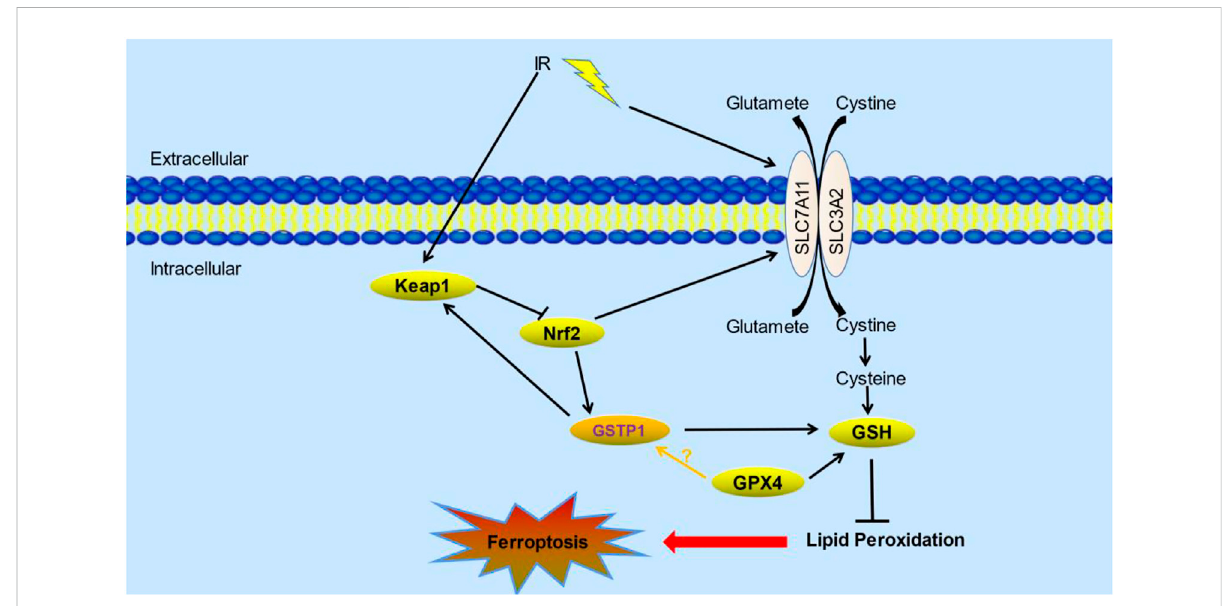
FIGURE 1 The potential role of GSTP1 and its mechanisms of ferroptosis in radiotherapy. Keap1-Nrf2-GSTP1 positive feedback loop interacts with GPX4 and SLC7A11 which are the core proteins in ferroptosis pathway under radiation. Their interactions affect lipid peroxidation, thus inhibiting the occurrence of ferroptosis (Liu et al., 2021; Wu et al., 2022). (IR: ionizing radiation; Keap1: kelch-like ECH associated protein 1; Nrf2: nuclear factor erythroid 2-related factor 2; GSTP1: Glutathione S-transferase P1; GSH: glutathione; GPX4: glutathione peroxidase